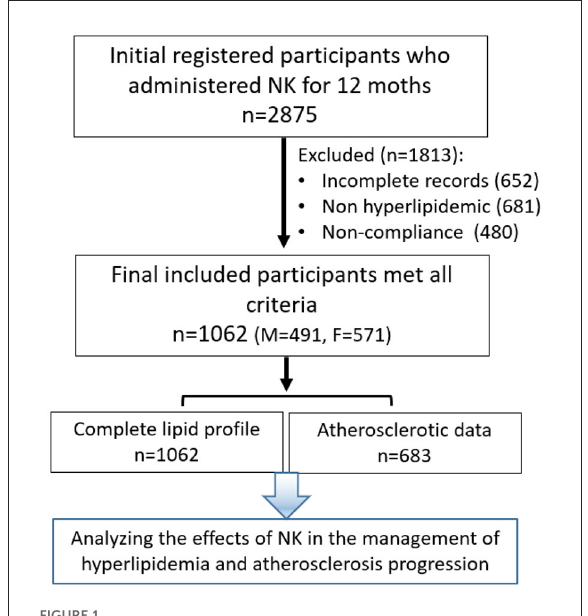
FIGURE1 Flow Chat Illustrating the Design and Methods of the Study.